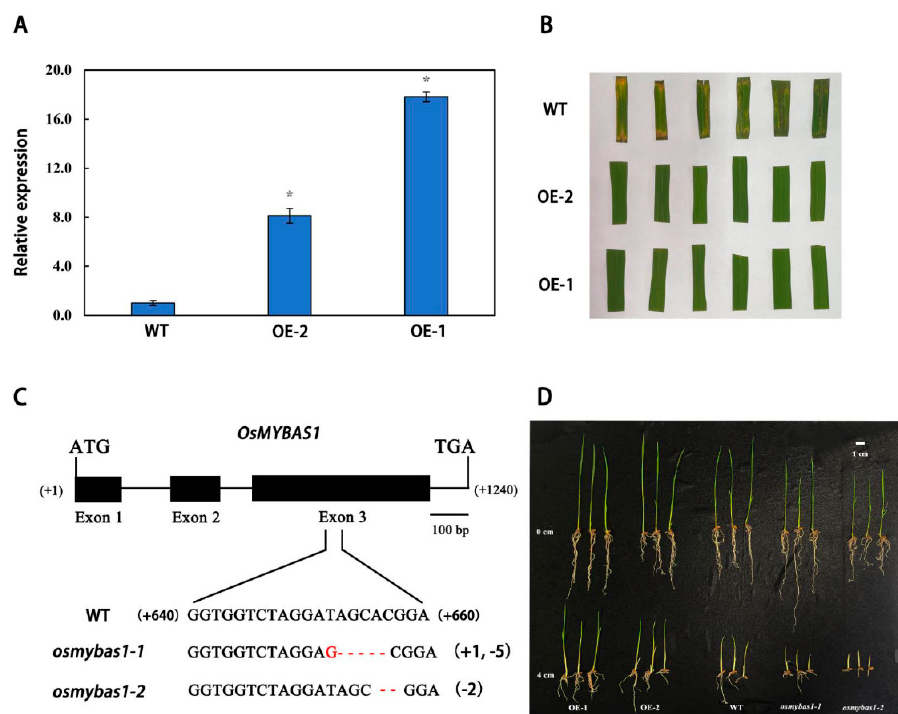
Figure 3. Identification and phenotype of OsMYBAS1 -overexpressing plants and osmybas1 mutants. ( A ) Relative expression of wild-type (WT) and two OsMYBAS1 -overexpressing rice lines (OE-1 and OE-2); ( B ) leaf phenotype of WT and osmybas1 mutants ( osmybas1-1 and osmybas1-2 ) soaked in Hygromycin solution; ( C ) two osmybas1 mutants ( osmybas1-1 and osmybas1-2 ) were obtained by sequencing and the knockout sites are presented; ( D ) phenotype of WT, OsMYBAS1 -overexpressing plants and osmybas1 mutants at the sowing depths of 0 and 4 cm, respectively. Data are mean ± SE of three biological replications. Asterisks indicate statistically significant differences ( p < 0.05, Duncan test) from the control (glume). Actin was used as an internal control.